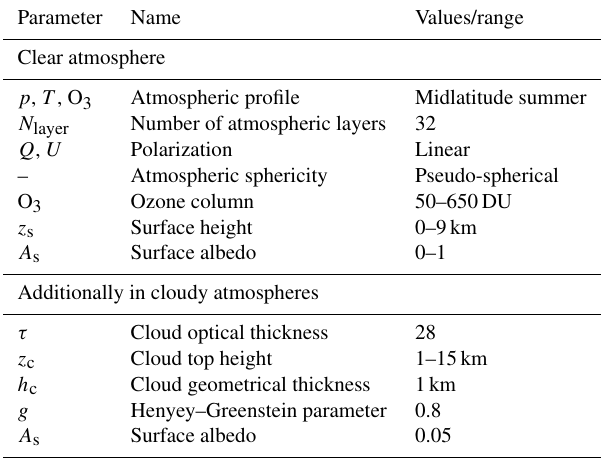
Table 1. Parameter settings used for the DAK radiative transfer model for clear and cloudy atmospheres.